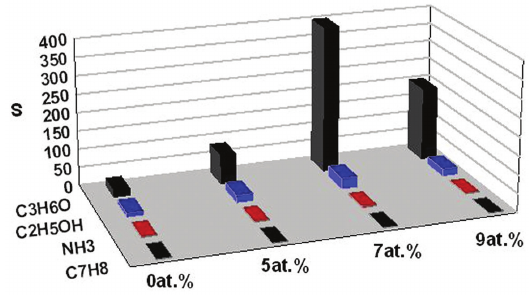
Figure 6. Sensitivity of different doping for various gases.